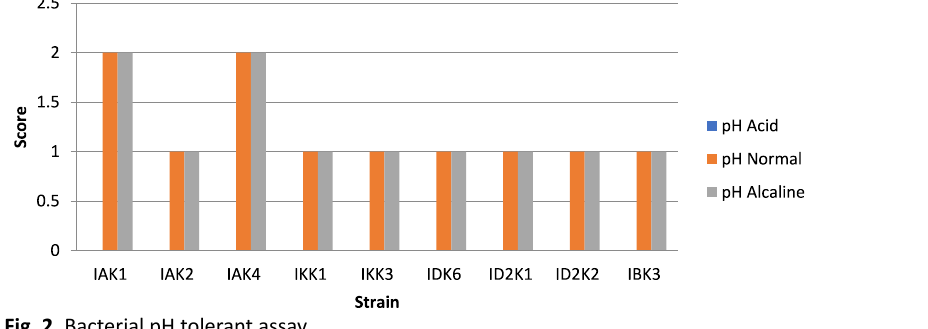
Fig. 2. Bacterial pH tolerant assay Description: Score null = none growth, Score1 = small colony, Score 2 = Large